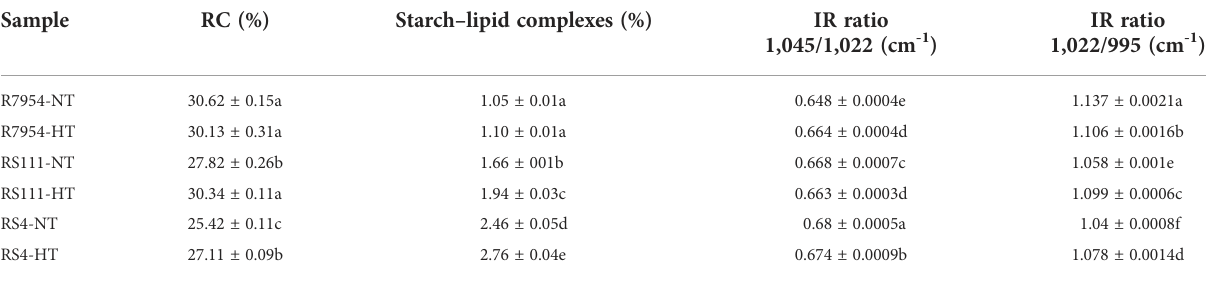
TABLE 3 RC and IR ratios of starches from R7954, RS111 and RS4 at NT and HT*. Sample